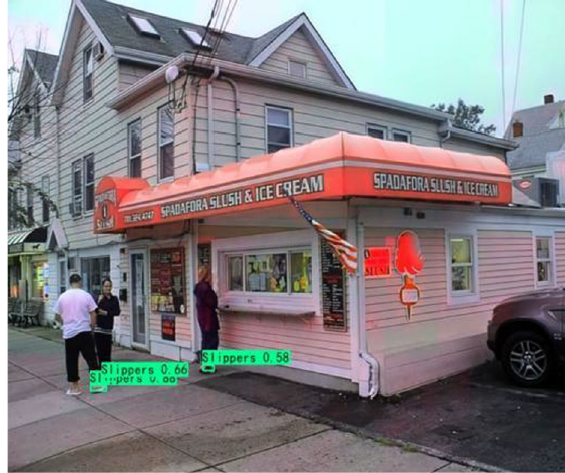
Fig. 14 Pseudo-RGB images 3(29th, 19th, and 9th